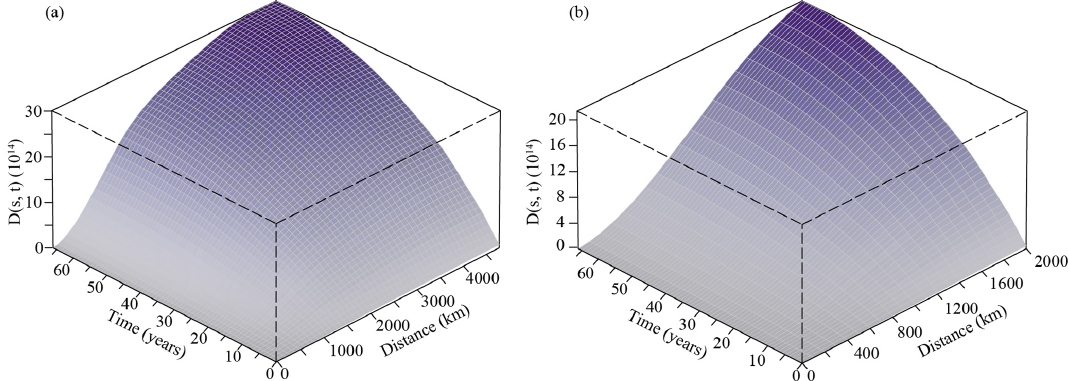
Figure 2. Perspective 3D plot of flash flood disasters in China during 1950–2015 (a) with a zoom up to 2000km (b) .